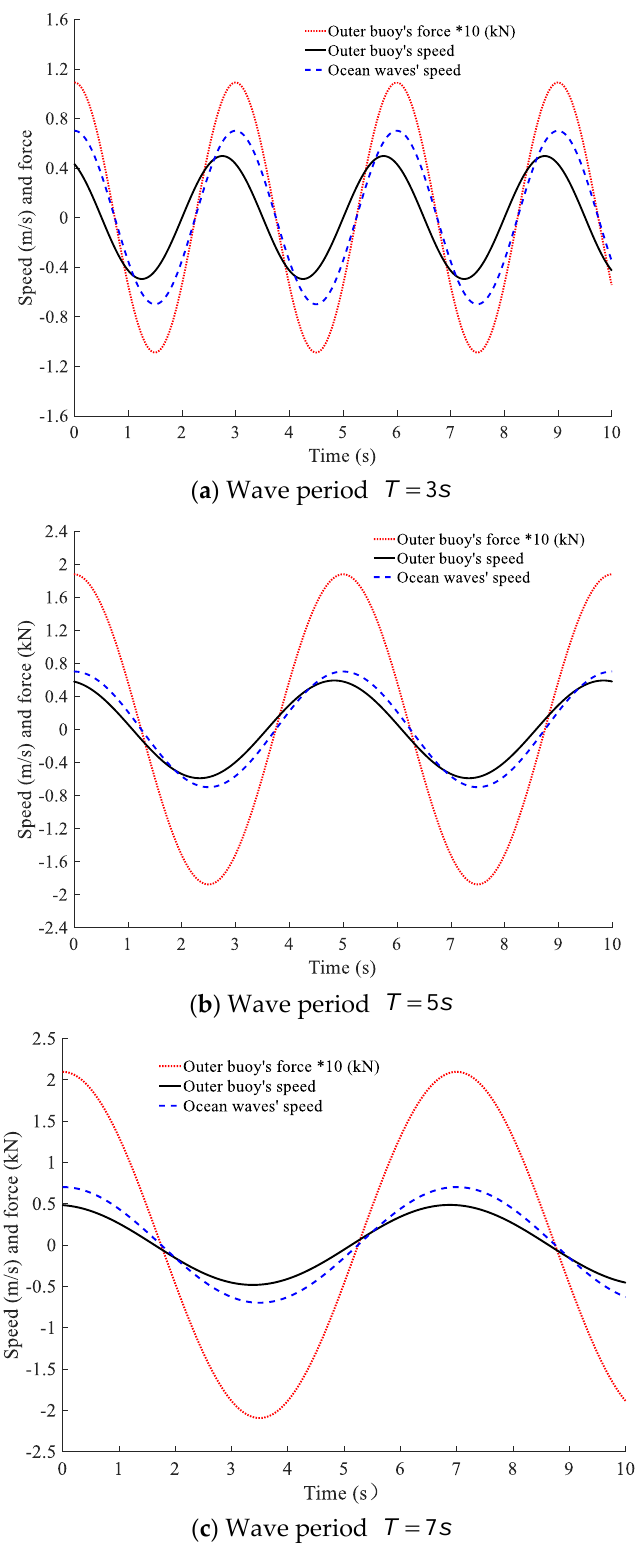
Figure 4. The vertical direction force and speed of outer buoy.